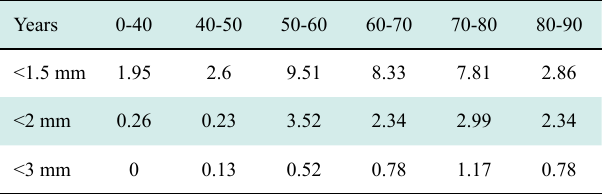
Table 1 Percentage distribution relationship between population with plaque disease and age